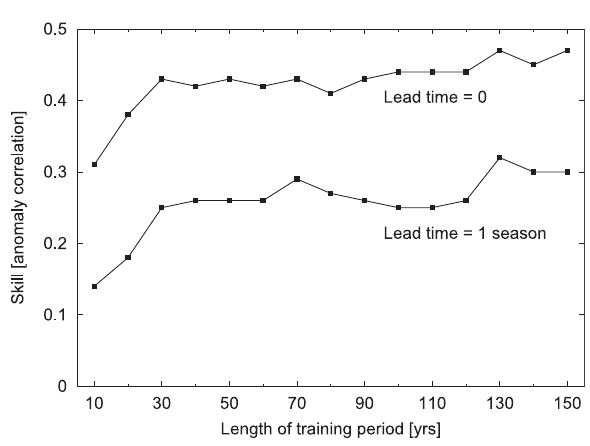
Fig. 13. Predictive skill as function of length of training period for statistical predictions of model simulated NAO index (see text) for JFM, years 151- 300. Top curve: predictions based on tropical SST from the same season (JFM). Bottom curve: predictions based on tropical SST from the previous season (OND).